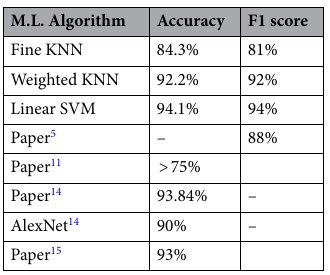
Table 14. Final results of the Machine Learning